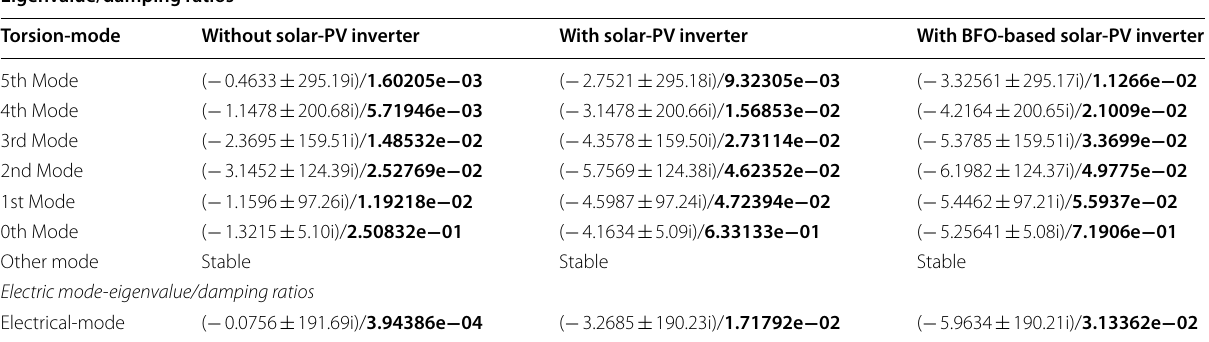
Table 4 Steady-state eigenvalues Eigenvalue/damping ratios Torsion‑mode Without solar‑PV inverter With solar‑PV inverter